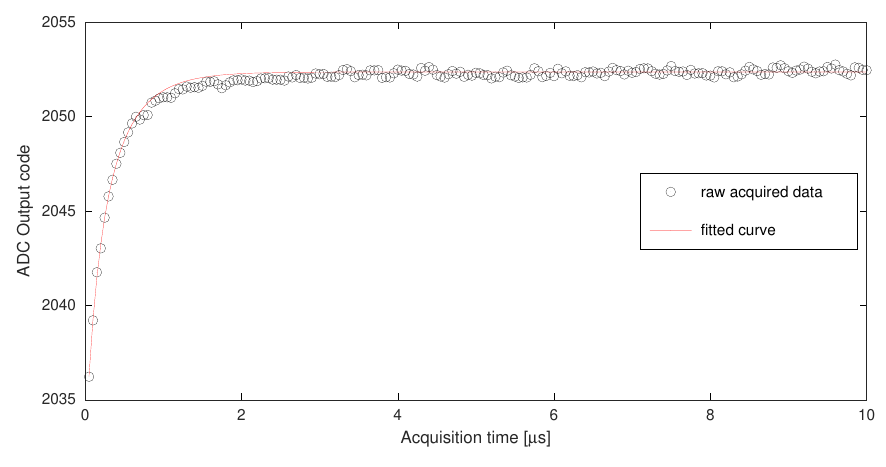
Figure 9. Acquired current fitting for zero load current.